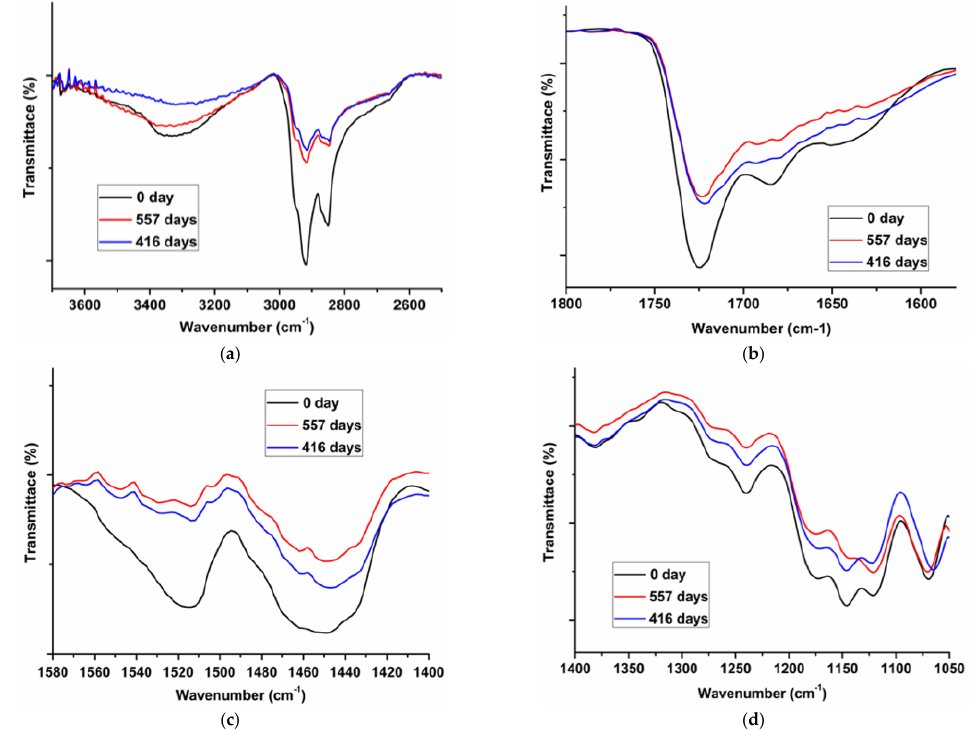
Figure 3. Windows of FTIR-ATR spectra of mirror A1 paint samples before and after exposure at the seaside site. ( a ) 3500–2500 cm −1 ; ( b ) 1800–1500 cm −1 ; ( c ) 1580–1400 cm −1 ; ( d ) 1400–1050 cm −1 .